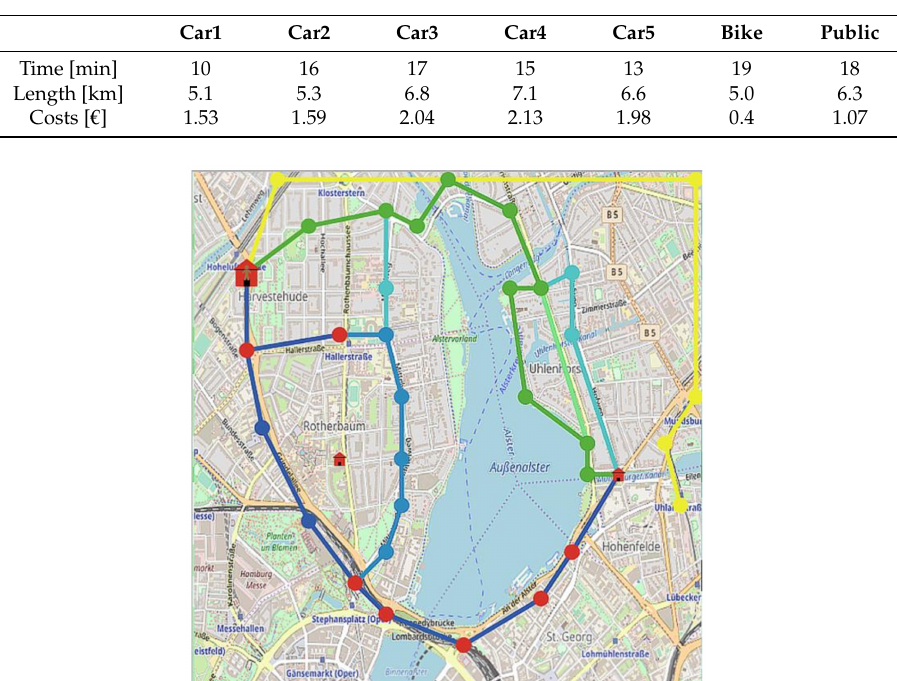
Figure 4. Map of commuting routes (colors) from home (small red house on the right) to work location (big red house in top left corner), in the prototype model; routes are the same for all of the agents. The third small house represents a day nursery. At each circle, the exposure of the agent is recalculated, implementing the agent-based model (ABM) in